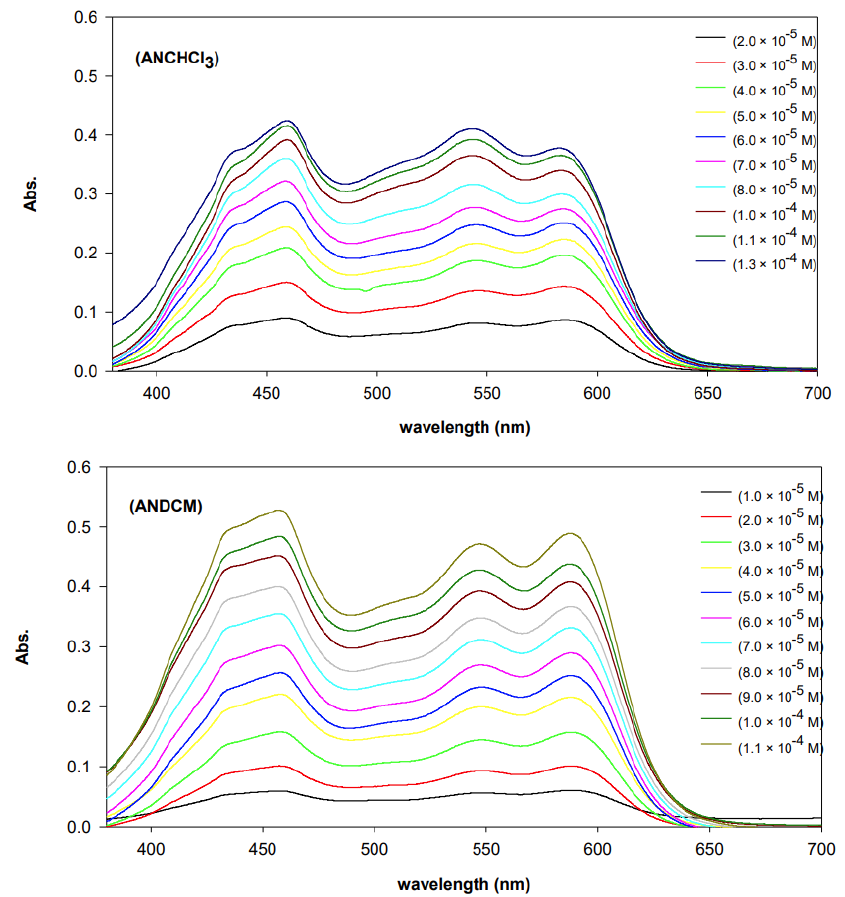
Figure 3. The electronic spectra of the AMFP – DDQ CT complex at different concentrations of AMFP in different solvents systems.